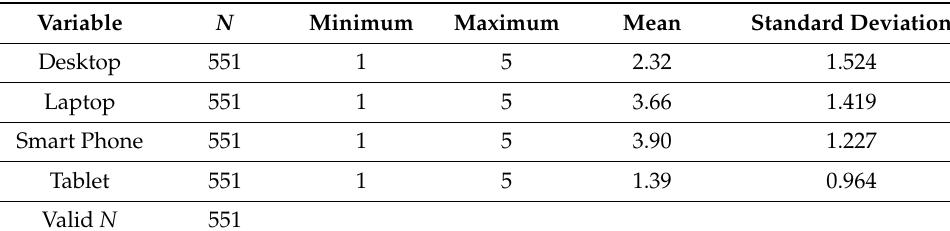
Table 21. Descriptive statistics of hardware tools used for online courses.